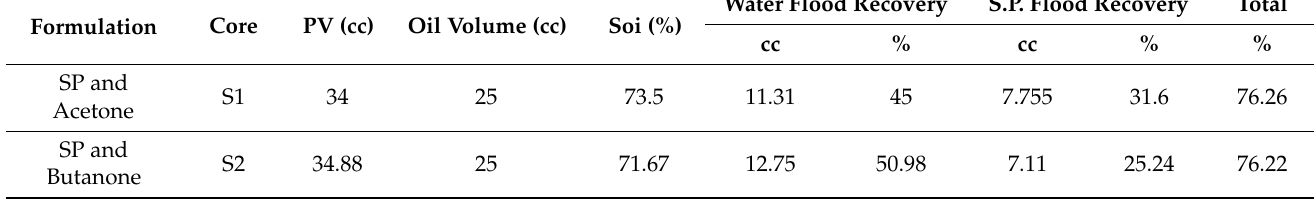
Table 10. Summary of the Two Formulations.